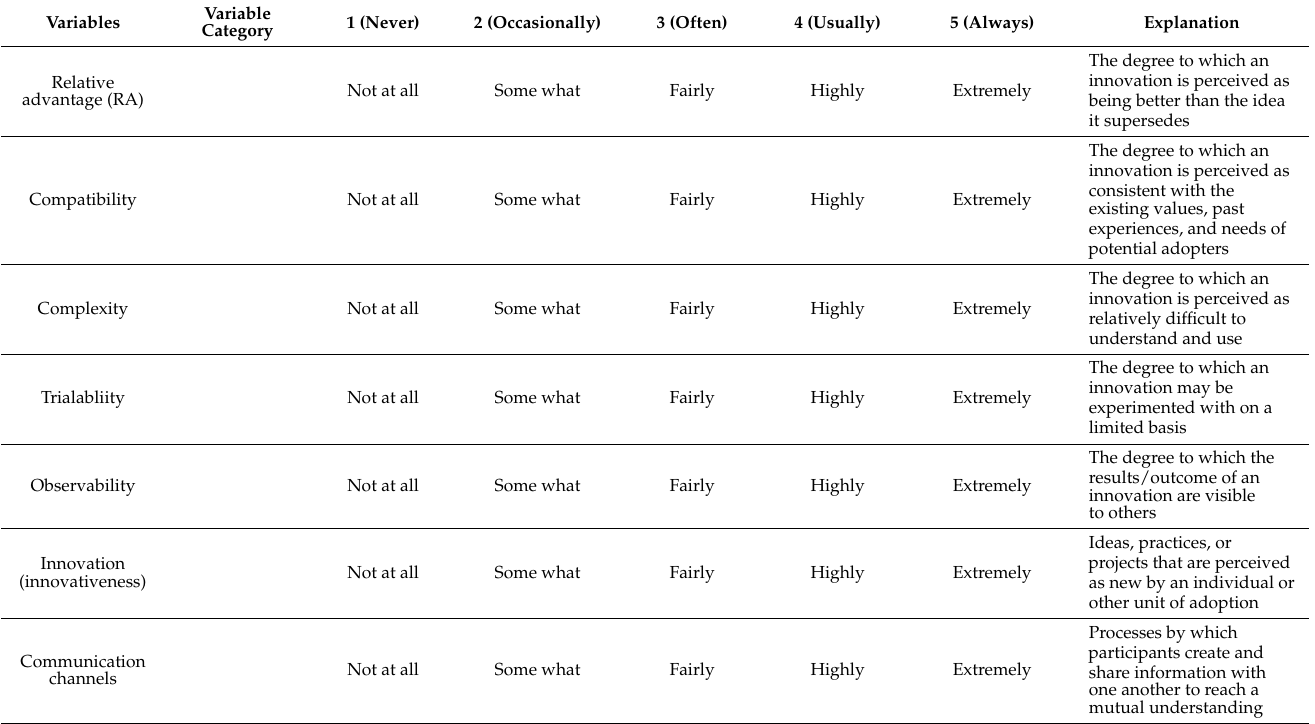
Table 1. Description of variable